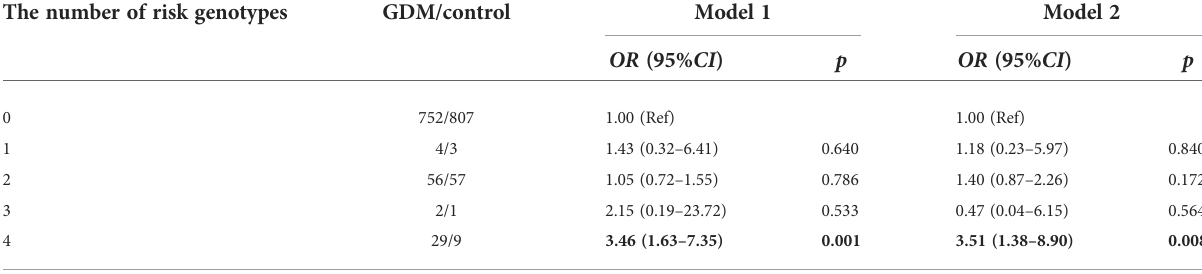
TABLE 3 Cumulative effects of risk genotypes in